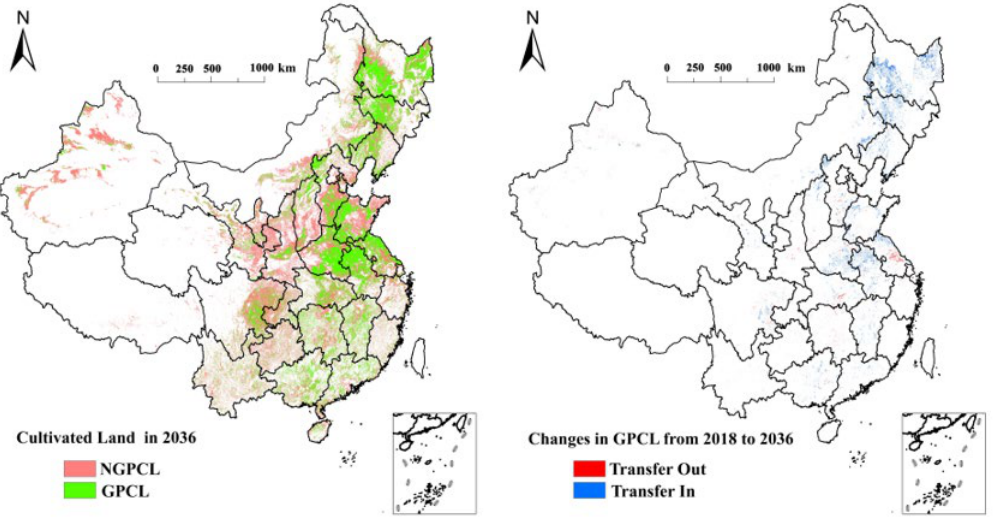
Figure 5. Estimated grain-producing cultivated land (GPCL) distribution and changes in 2036.